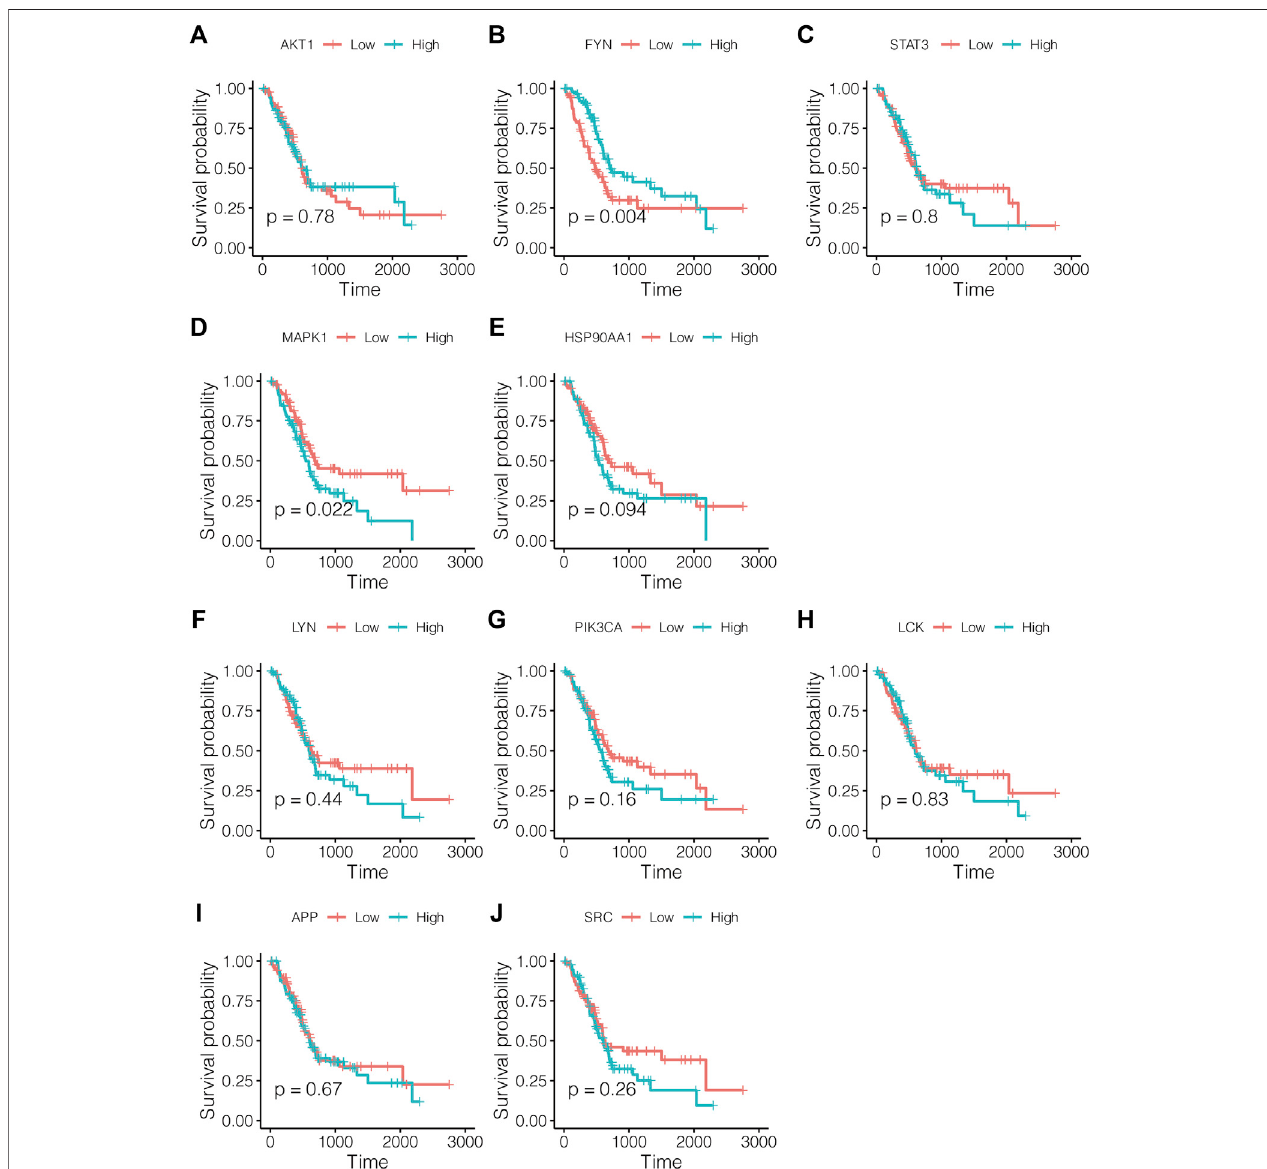
FIGURE 4 | Survival analysis for study effects of 10 core targets in pancreatic cancer patients. Red lines represent sample groups with low gene expression, while blue lines represent sample groups with high gene expression. (A) AKT1, (B) FYN, (C) STAT3, (D) MAPK1, (E) HSP90AA1, (F) LYN, (G) PIK3CA, (H) LCK, (I) APP, and (J)